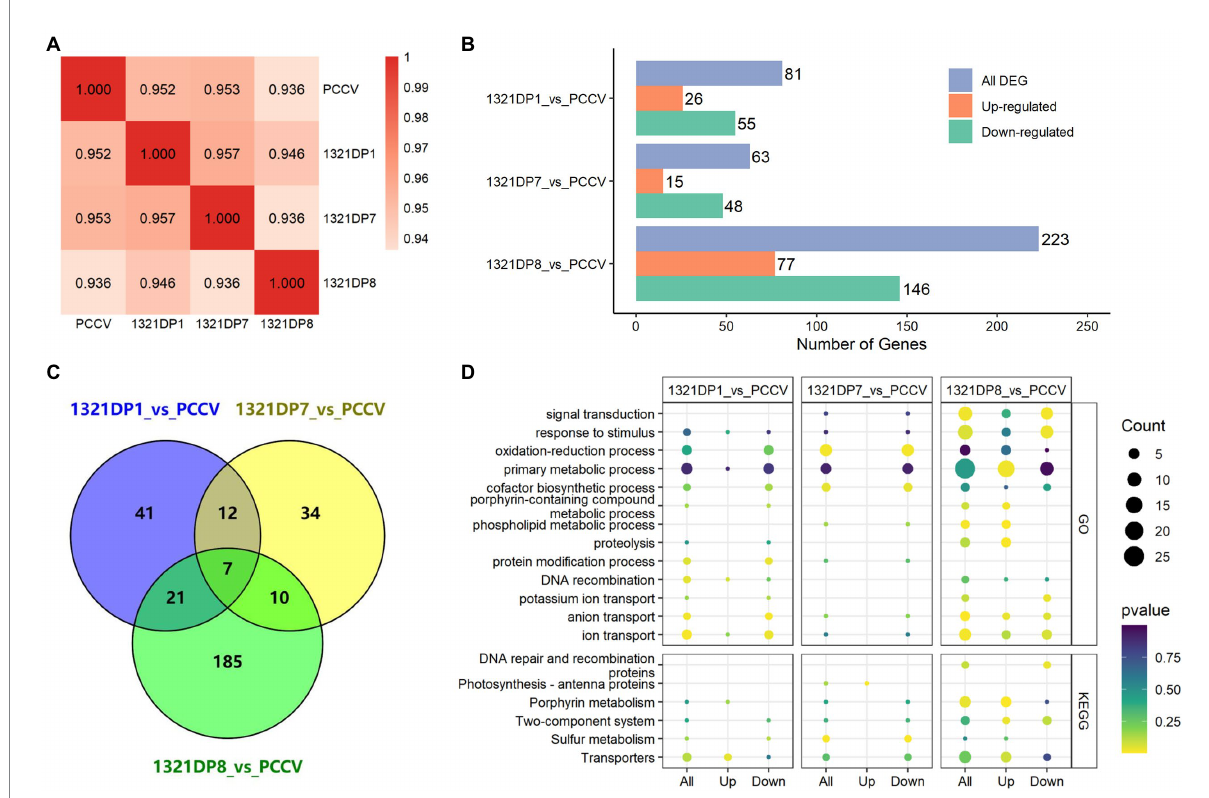
FIGURE 2 RNA-seq results analysis. (A) Pearson correlation analysis between samples. (B) Number of DEGs in three mutants. (C) Venn diagram of the DEGs in three mutants. (D) Pathway enrichment analysis results using